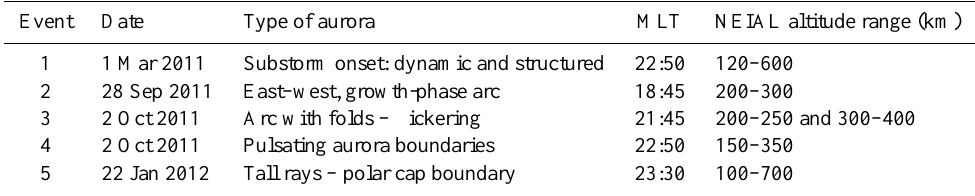
Table 3. Summary of the auroral events examined and the distinguishing NEIAL characteristics.